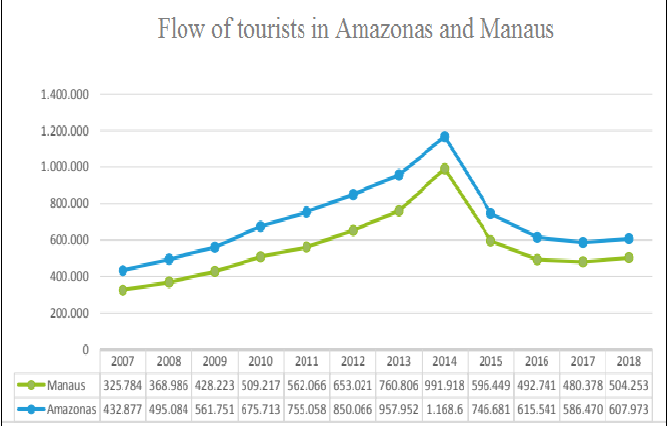
Figure 1: Flow of tourists in Amazonas and Manaus. Source: